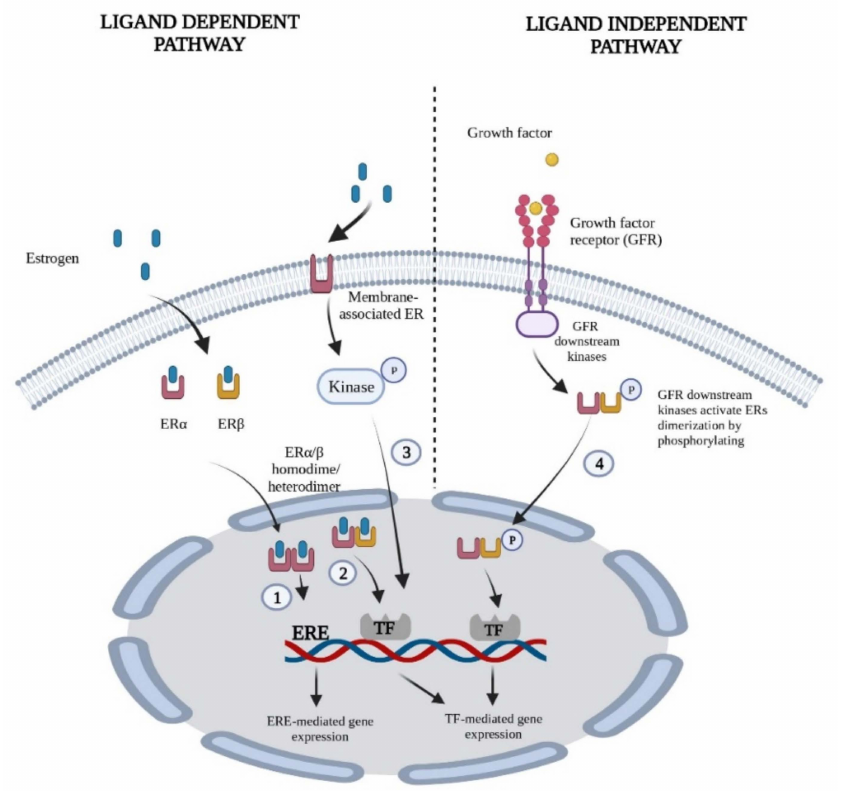
Figure 3. Illustration of ER signaling pathways. In ligand-dependent signaling, 1: Estrogen binds to intracellular ER and translocates to nucleus for binding to estrogen response elements (EREs) in target gene promoters regulating estrogen-responsive genes, 2: Estrogen binds to intracellular ER and translocates to nucleus for binding to transcription factors (TFs), 3: Estrogen binds to membrane- associated ER and induces signaling molecules, including Src tyrosine kinase, mitogen-activated protein kinase (MAPK), PI3K/AKT, and protein kinase C, regulating transcription of target genes by phosphorylating transcription factors. In ligand-independent signaling, 4: Growth factors bind to growth factor receptors (GFR) to activate intracellular kinases. GFR downstream kinases activate ERs dimerization by phosphorylation and regulate target gene expression in absence of estrogen in both ERE-dependent nuclear signaling or by interacting with other transcription